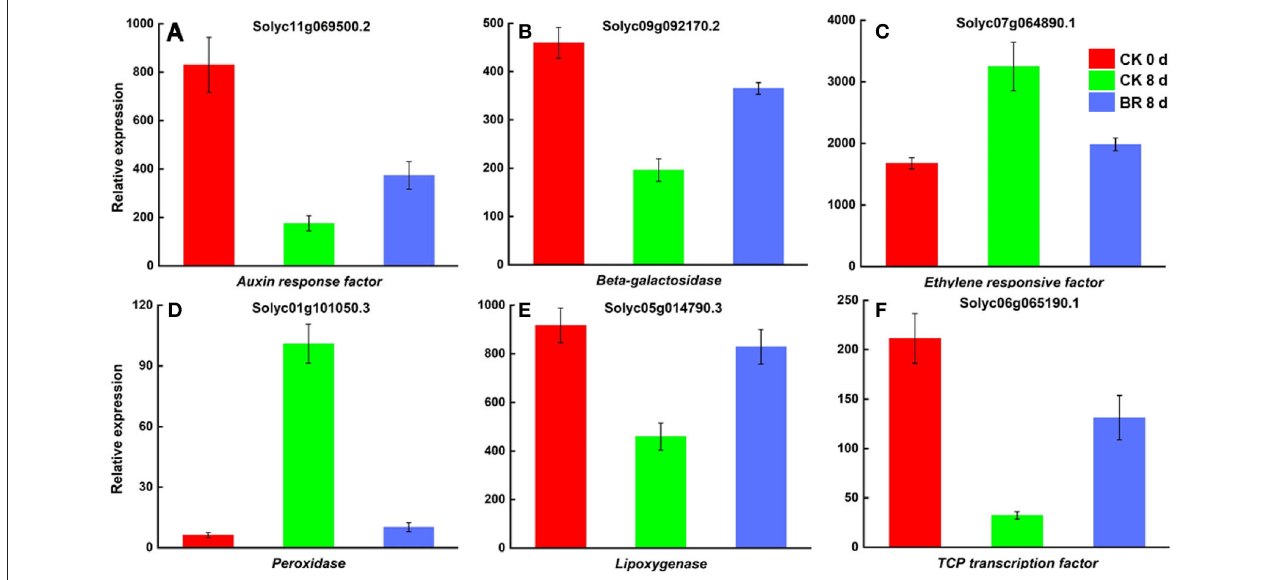
FIGURE 5 | DEGs in tomato fruit CI process regulated by BR. (A) Relative expression of mRNA encoding Auxin response factor (ARF) . (B) Beta-galactosidase ( β -GAL) . (C) Ethylene responsive factor (ERF) . (D) Peroxidase (POD) . (E) Lipoxygenase (LOX) . (F) TCP transcription factor 13 .